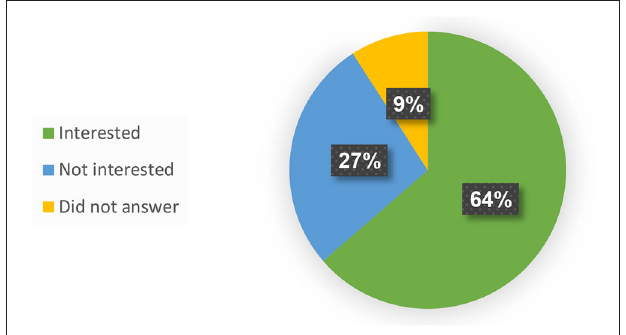
FIGURE 2 | Interest of individuals post-stroke in practicing with a robot as part of the rehabilitation process.